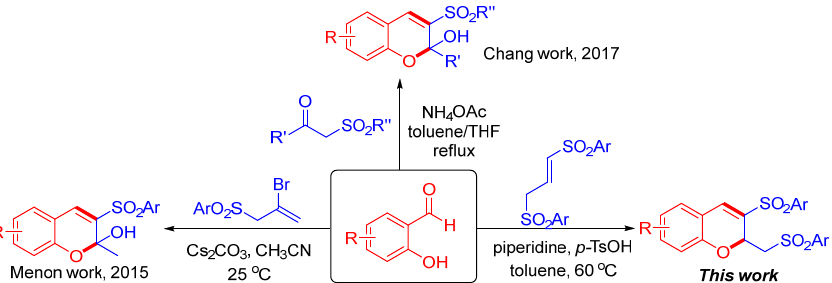
Figure 1. Biologically active 2 ‐ substituted 2 H ‐ chromene molecules.